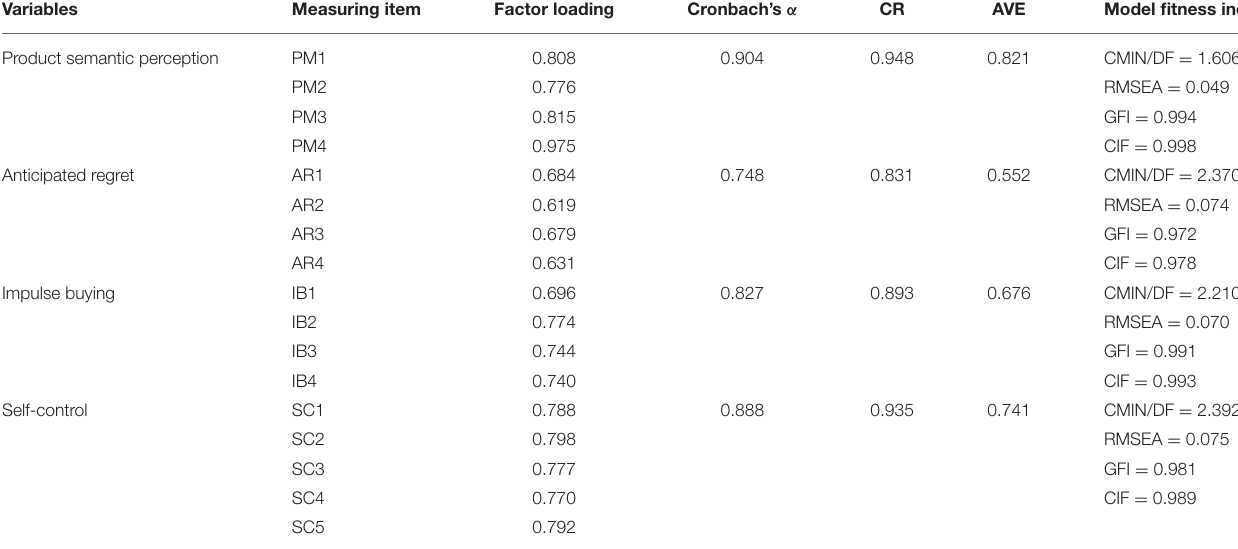
TABLE 2 | Reliability and